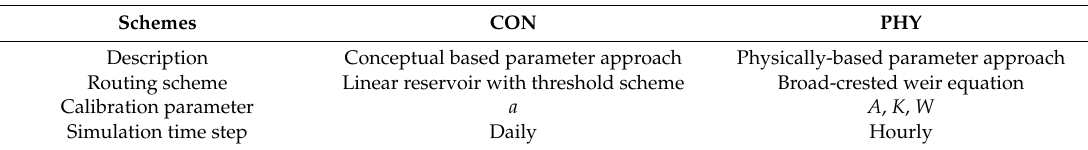
Table 2. Overview of the conceptual and physically-based parameterization approaches compared in this